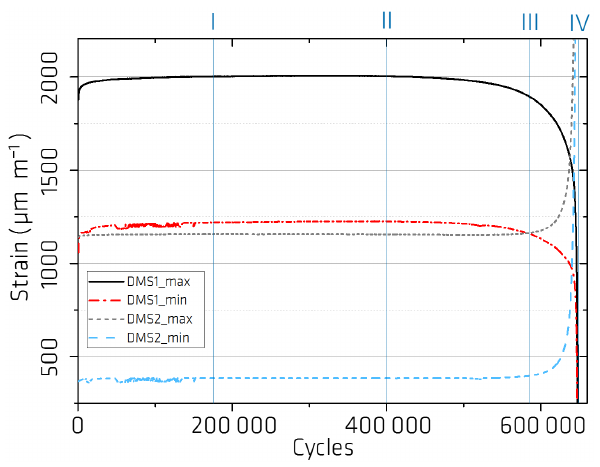
Figure 9. Evolution of strain (butt weld) with stages of crack de- tection: I) no changes in the luminescence coating, II) first weak blinking, III) clearly visible crack, IV) fracture of the